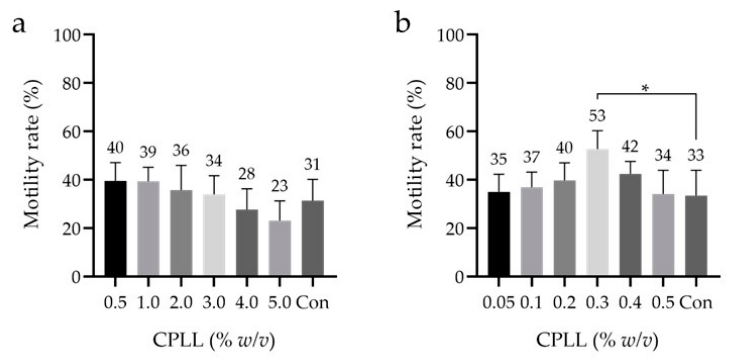
Figure 3. Sperm motility rates after freeze–thawing with cryopreservation reagents containing dif- ferent concentrations ( ≤ 5% w / v ) of the macro-Mw CPA CPLL. ( a ) The concentrations of CPLL ranged from 0.5% to 5% w / v . ( b ) The concentrations of the macro-Mw CPA CPLL ranged from 0.05% to 0.5% w / v with 7% v / v Glyc as the low-Mw CPA and no additional saccharides used. Dunnett’s test was performed; p -value < 0.05 was considered statistically significant. The data are expressed as the means ± standard deviations ( n = 9). Asterisks (*) indicate a statistically significant difference; low-Mw CPA, low-molecular-weight cryoprotective agent; macro-Mw CPA, macromolecular- weight cryoprotective agent; Con, commercial cryopreservation reagent (Fujifilm Irvine).